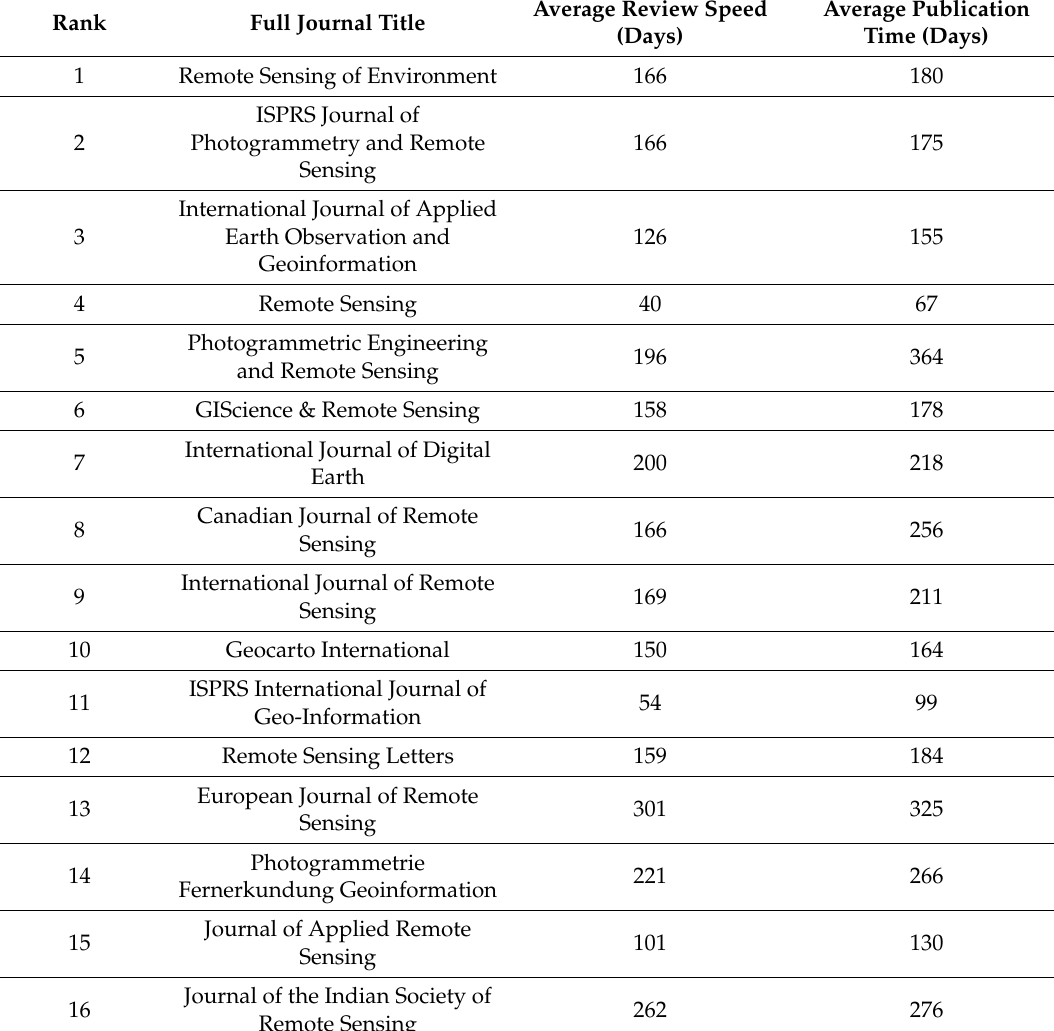
Table 2. Publication time of various remote sensing